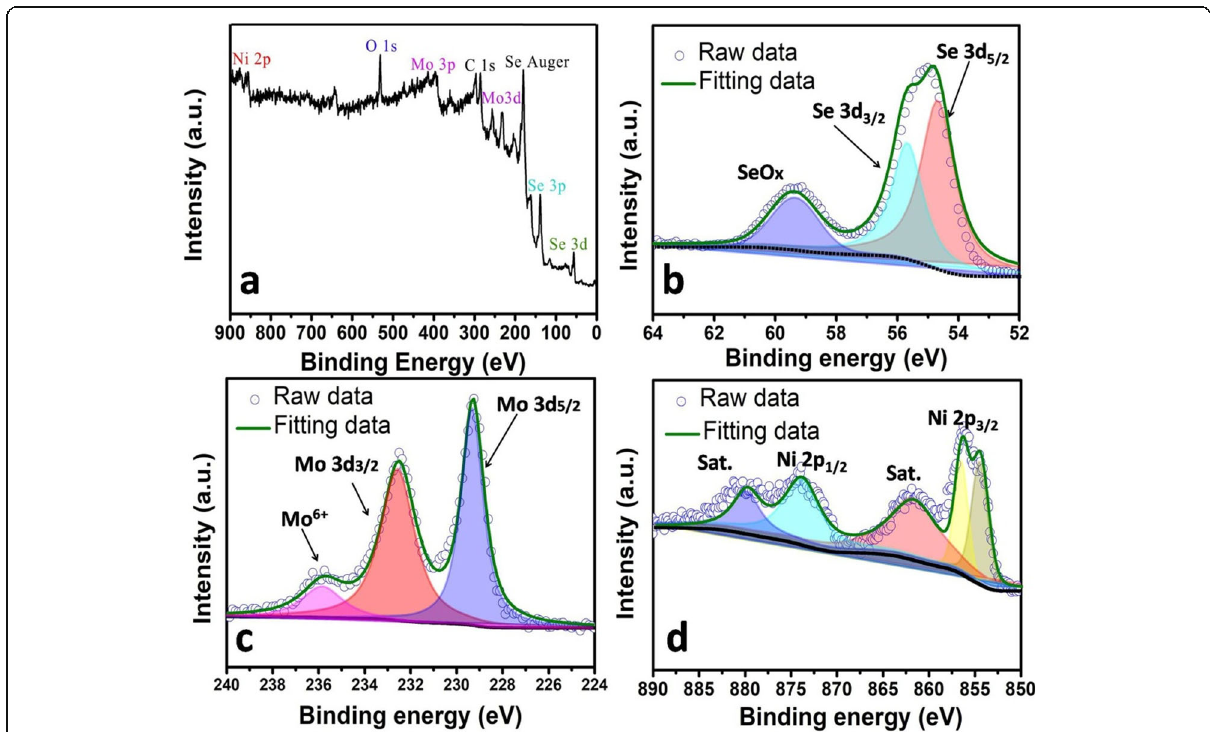
Fig. 5 XPS spectra of Mo2Ni1 sample. a is the survey spectrum. b ), c , and d show the expanded spectra of Se, Mo, and Ni,